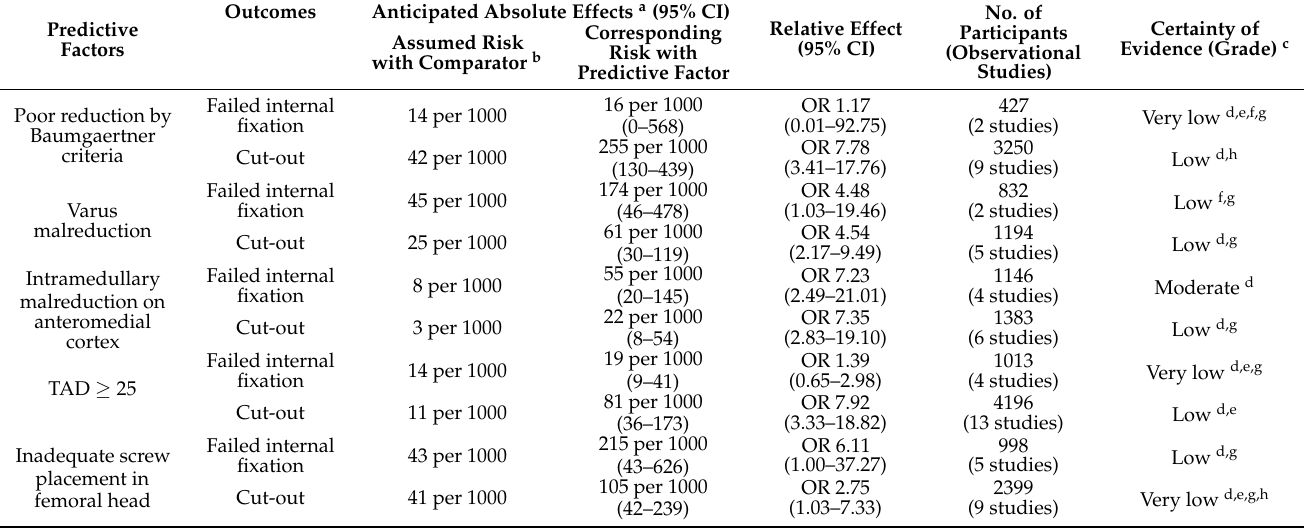
Table 1. Summary of findings on association of immediate postoperative radiographic findings and failed internal fixations in patients treated with internal fixation for trochanteric